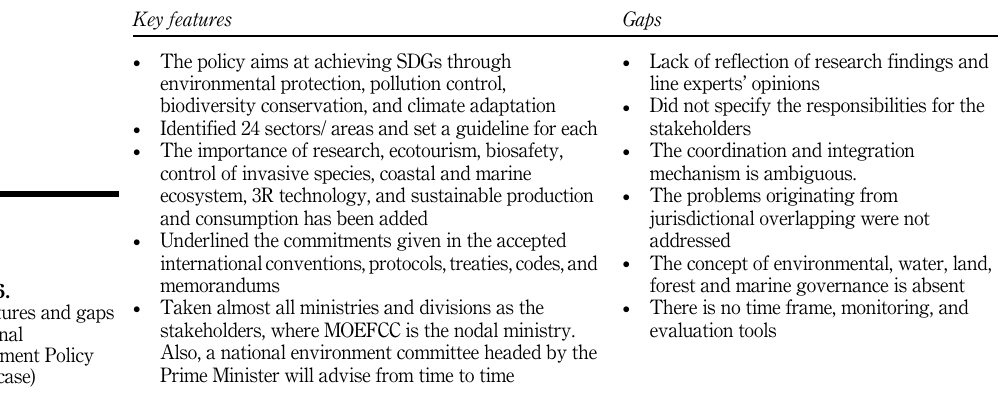
Table 6. Key features and gaps of National Environment